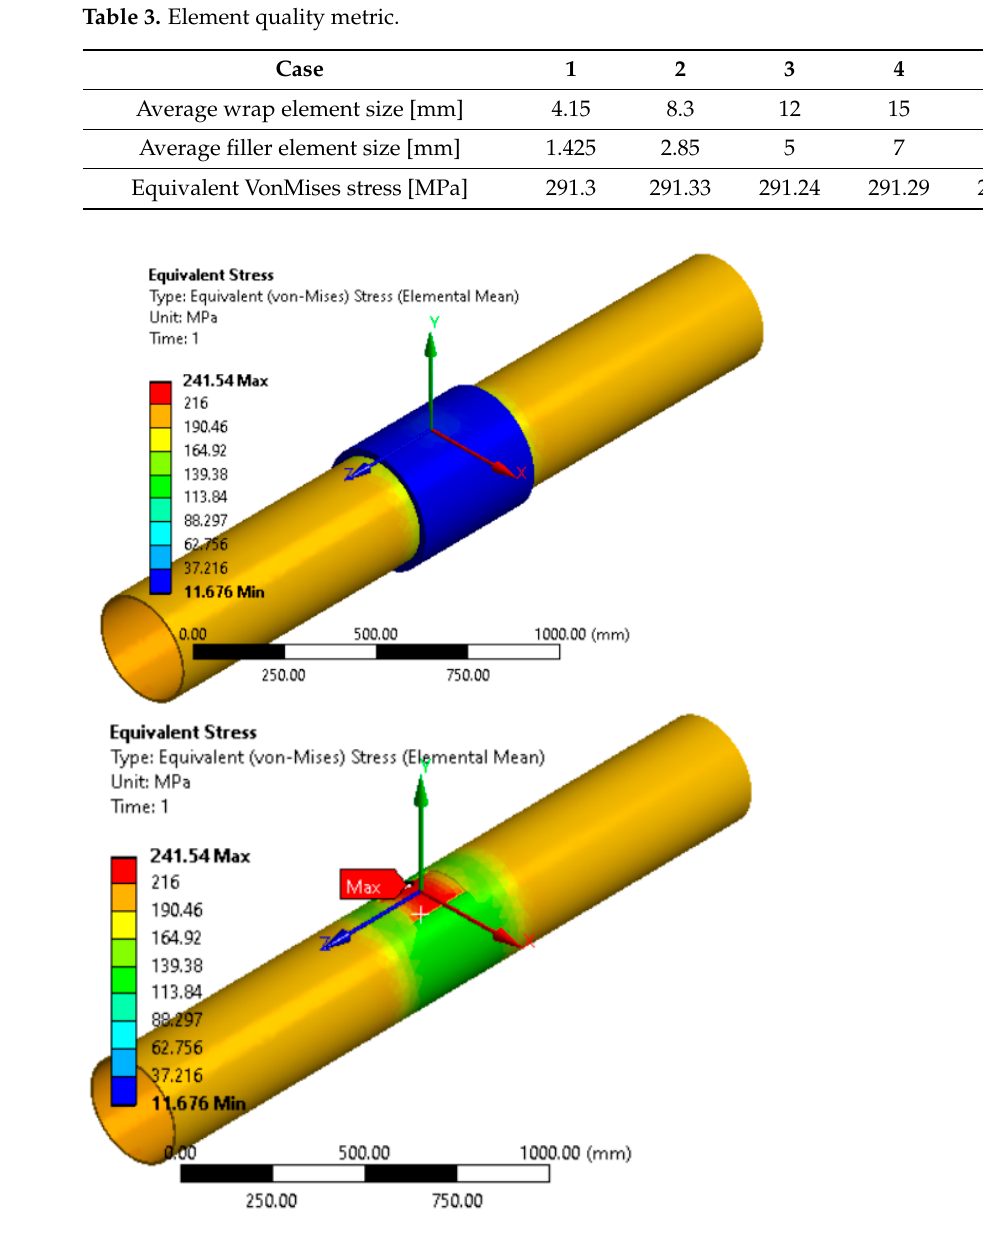
Figure 7. FEA analysis for an X42 steel pipe with a straight local metal loss defect, repaired using type III composite material wrap: D e = 323.9 mm; t n = 9.5 mm; d max = 4.75 mm; s p = 220 mm; Cp = 150 mm; t cw = 23 mm; l cw = 440 mm.